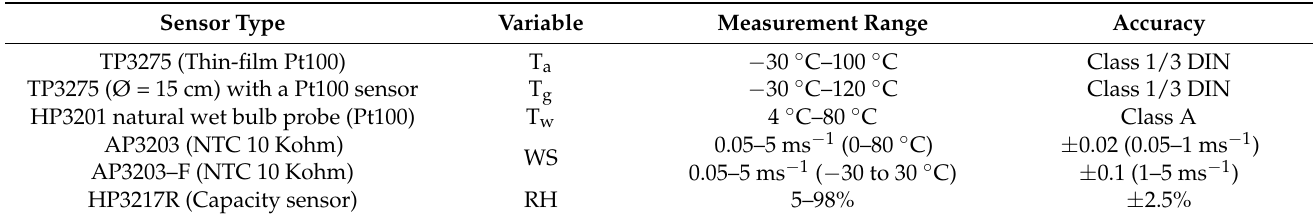
Table 1. Information about sensor types, accuracies, and ranges used in field